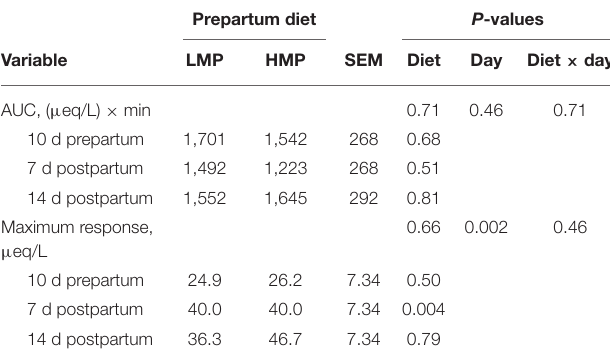
TABLE 7 | Area under the curve (AUC) for glucose and maximal glucose response in plasma to epinephrine administration in dairy cows fed low (L) or high (H) amounts of metabolizable protein (MP)